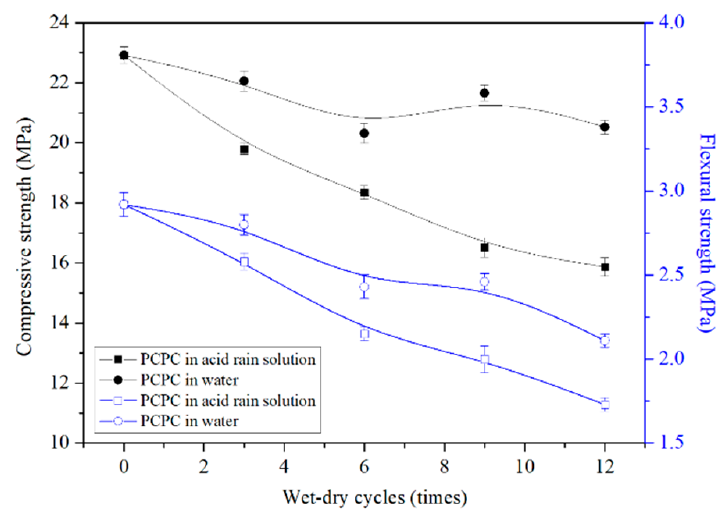
Figure 3. Strength of control PCPC.